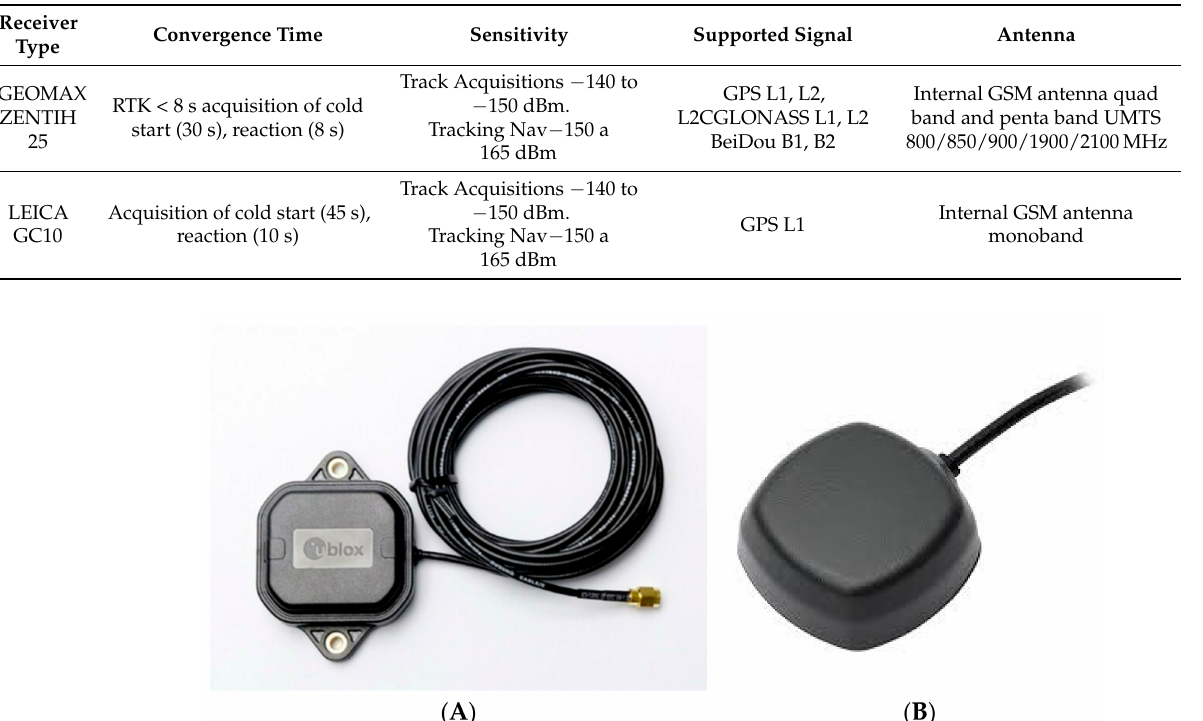
Figure 1. ( A ) ANN-MB multiband antenna; ( B ) Tallysman TW4721 antenna.